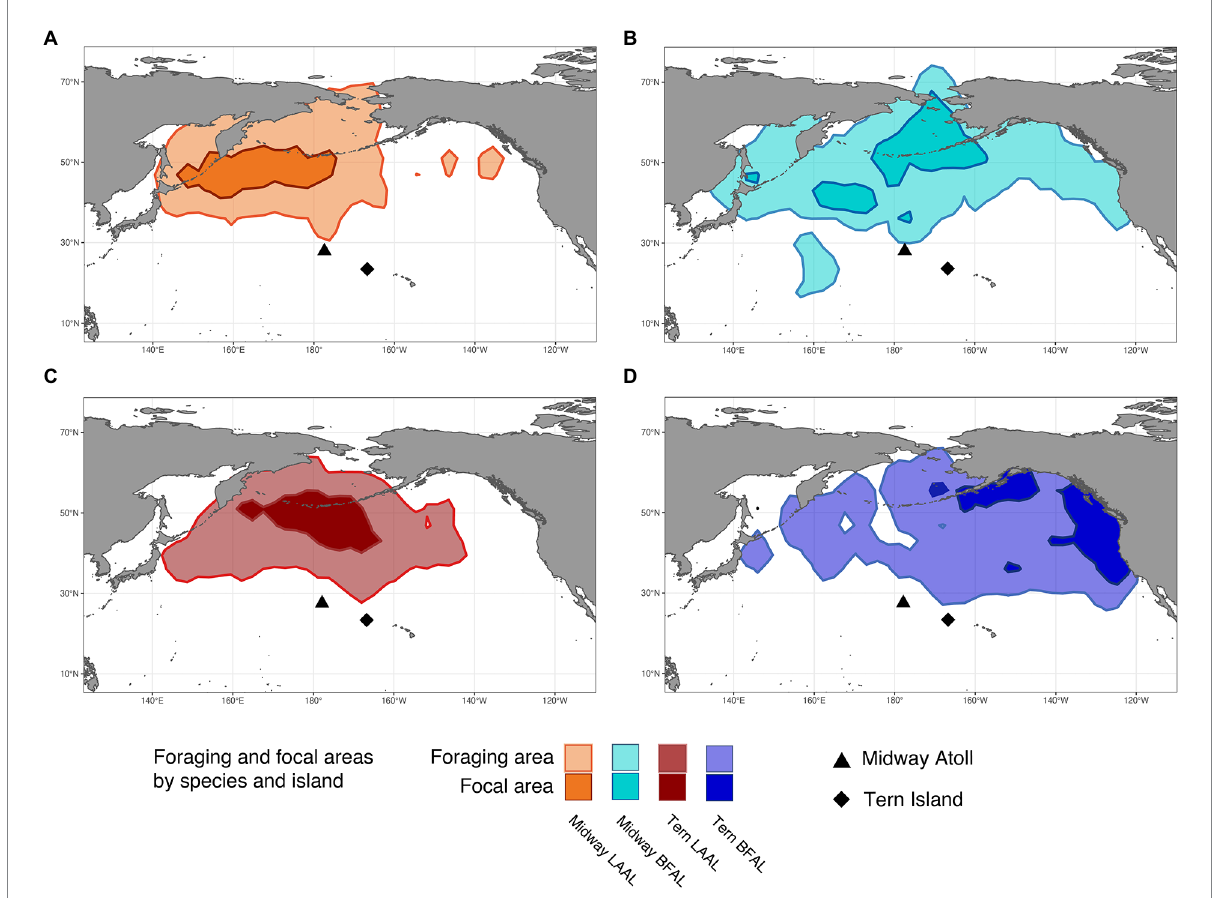
FIGURE 2 Foraging and focal areas (95 and 50th utilization distributions, respectively) for: (A) Midway Laysan albatross, (B) Midway black-footed albatross, (C) Tern Laysan albatross, and (D) Tern black-footed